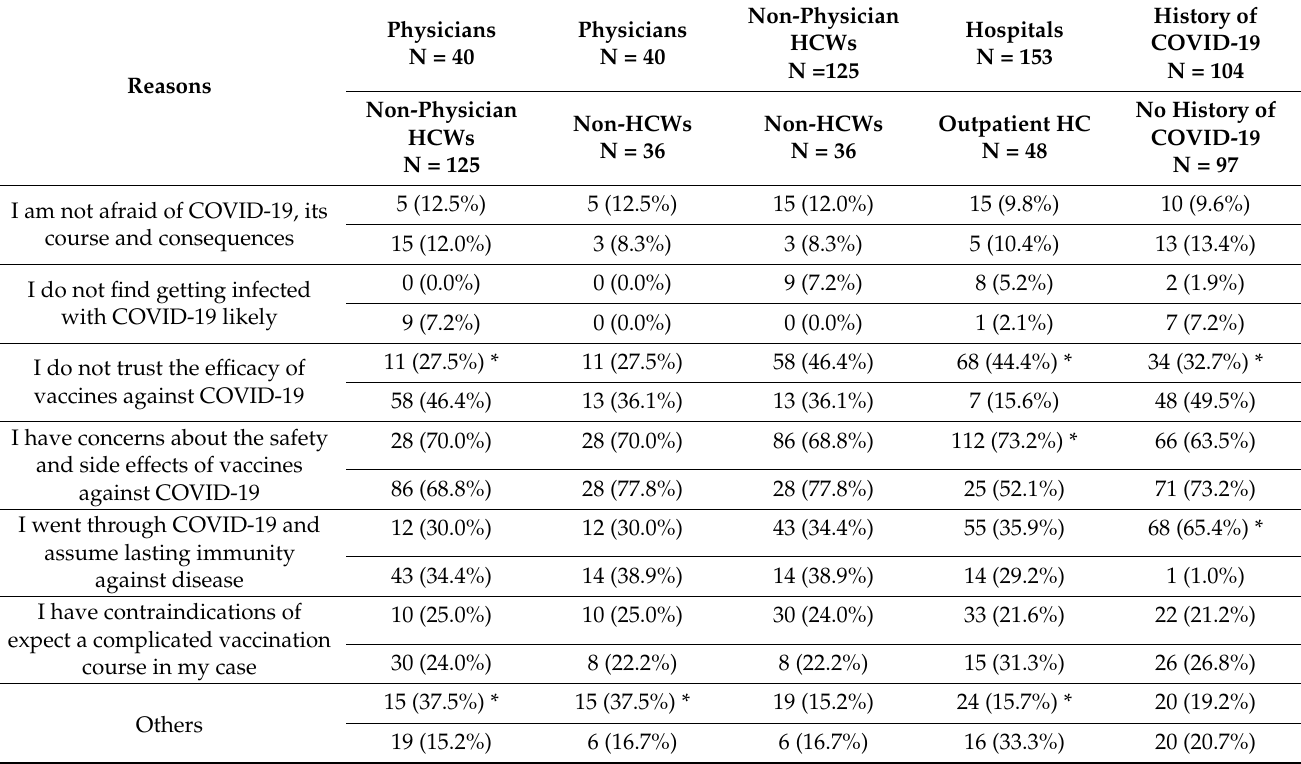
Table 3. Reasons for personal COVID-19 vaccine hesitancy (unvaccinated group, N = 201) according to selected variables (occupation and history of COVID-19).